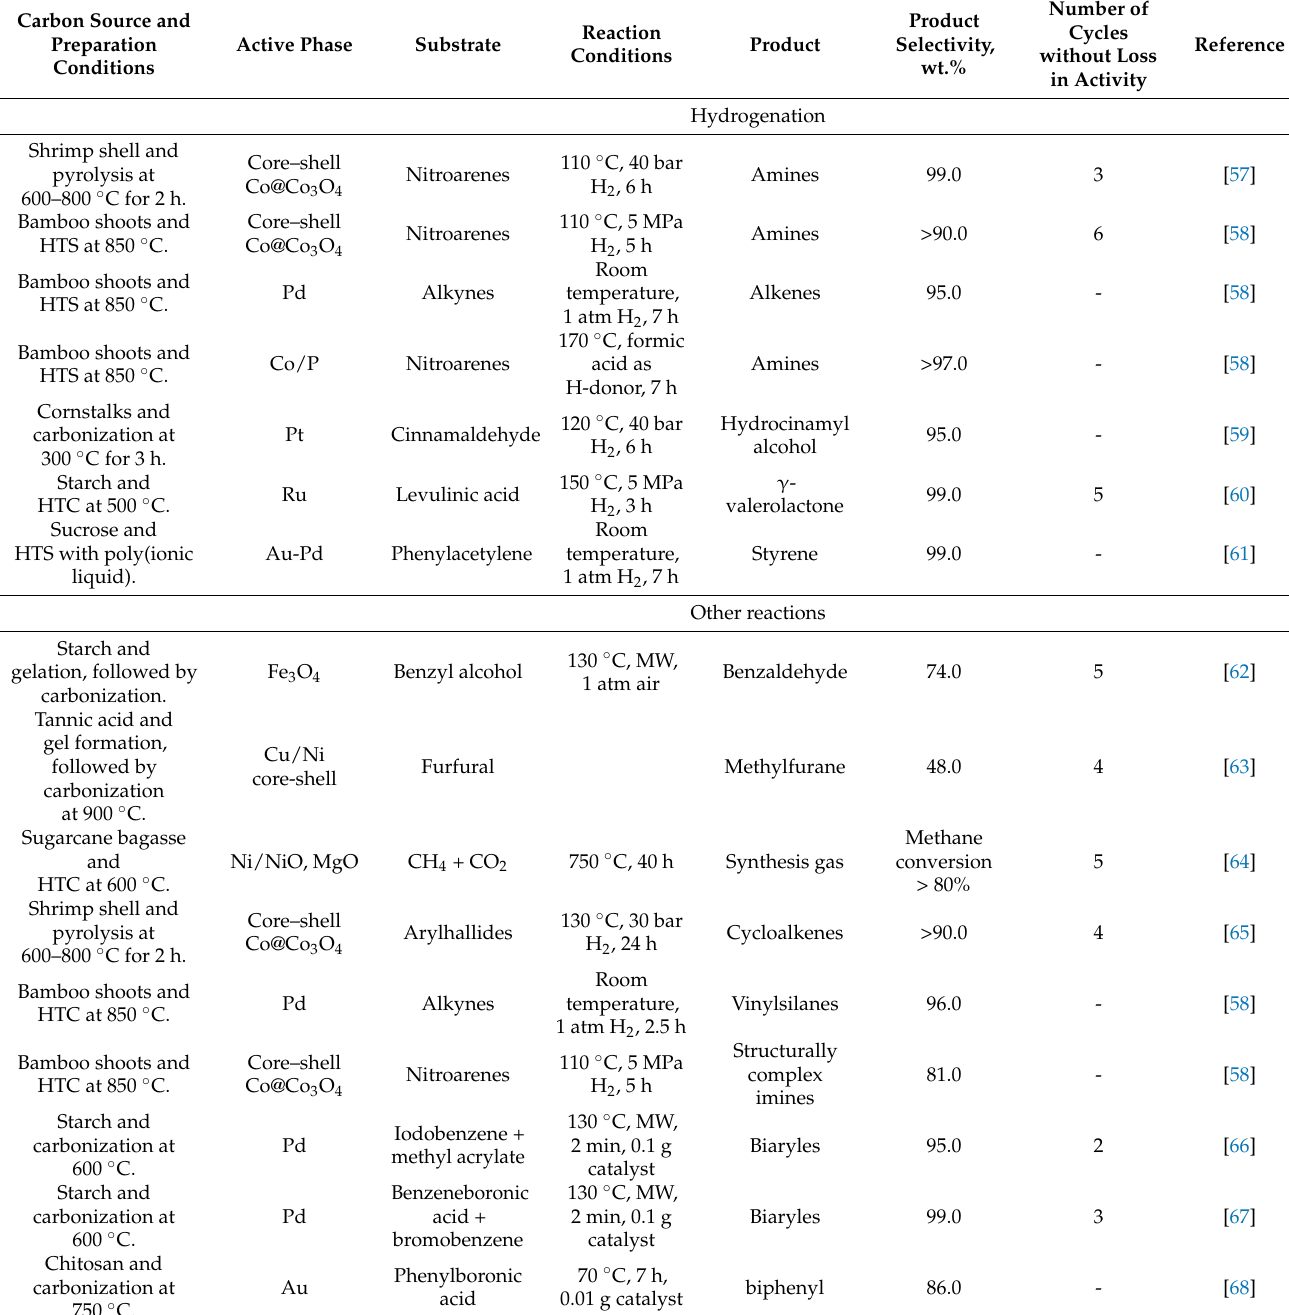
Table 4. Summary of biomass-derived carbon-based catalysts for organic